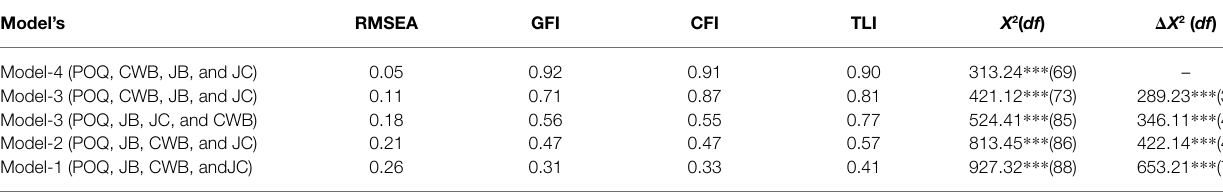
TABLE 3 | Measurement model comparison ( N = 317). Model’s